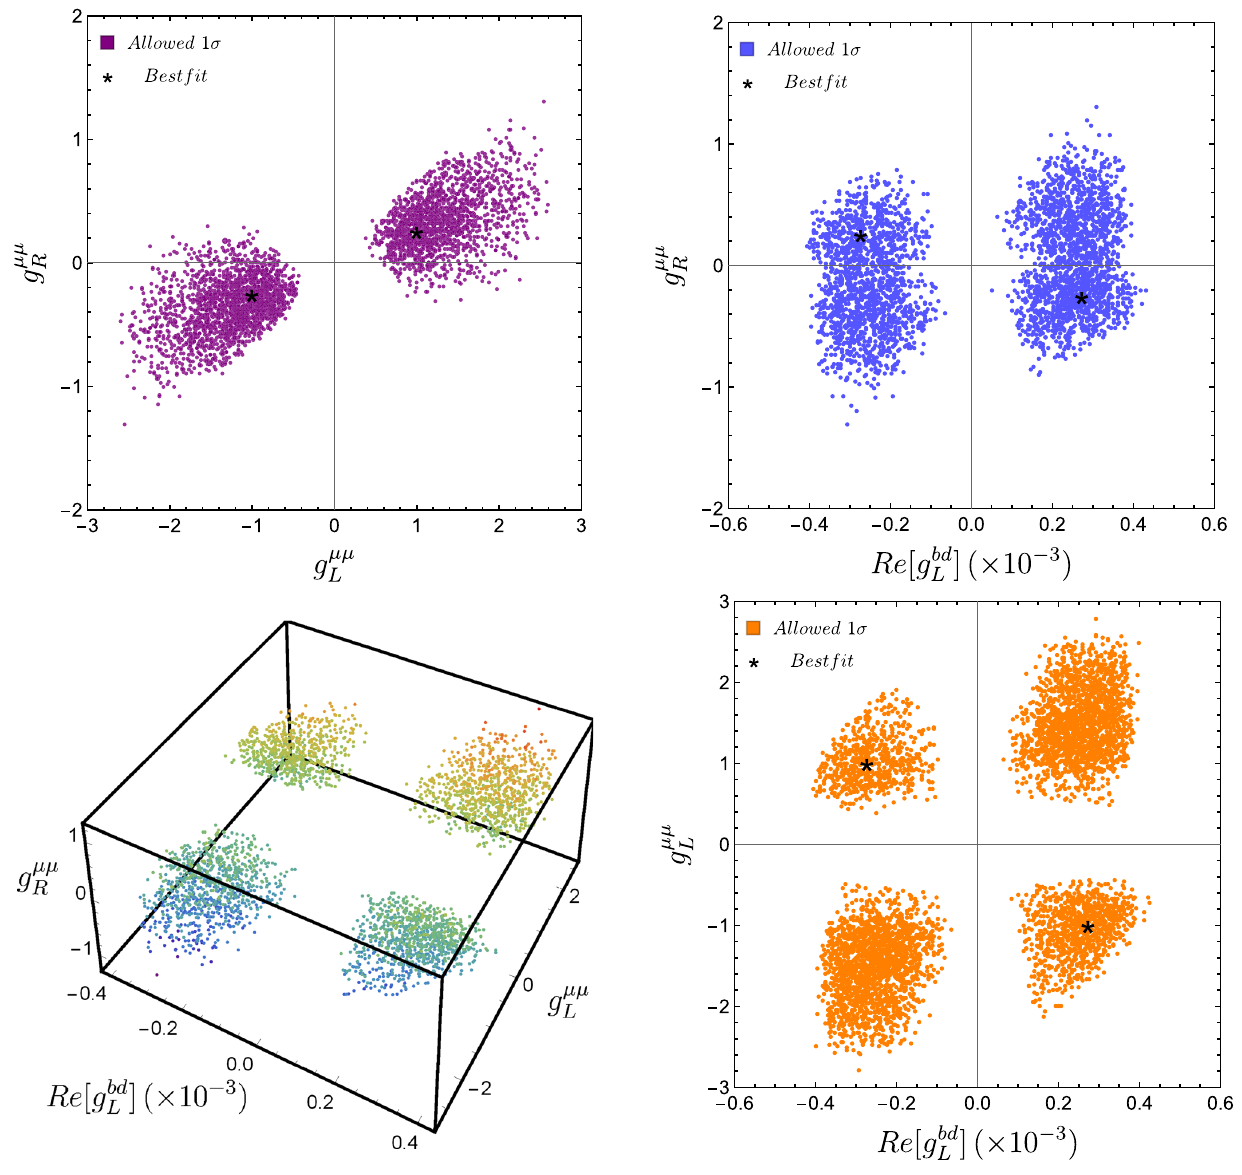
μμ ] , g μμ , g ) parameter space for a Z (cid:3) model with complex couplings, for M Z (cid:3) = 1 TeV. The colors red to blue in L R L